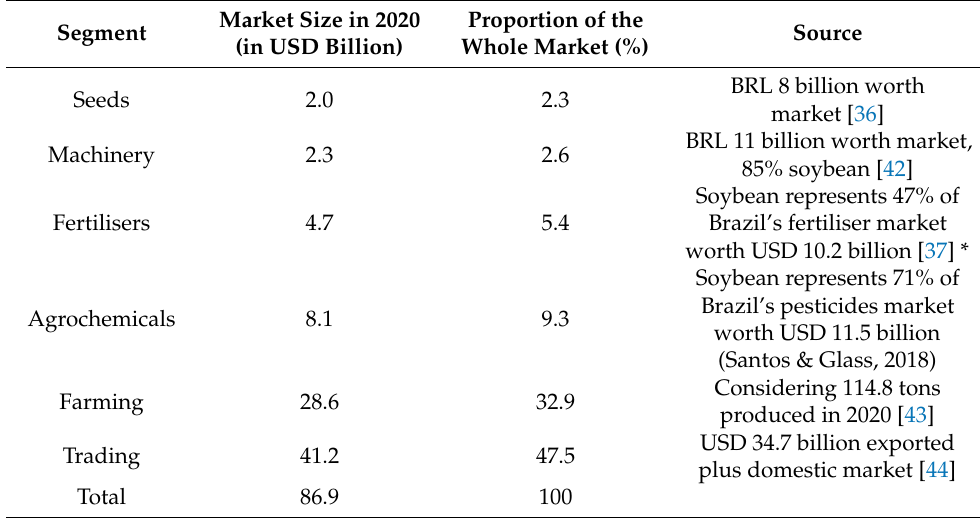
Table 3. Market size of each business segments (in USD